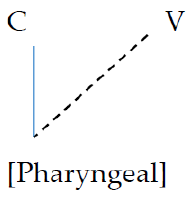
Figure 4. Hebrew guttural lowering (McCarthy 1994, p. 210).